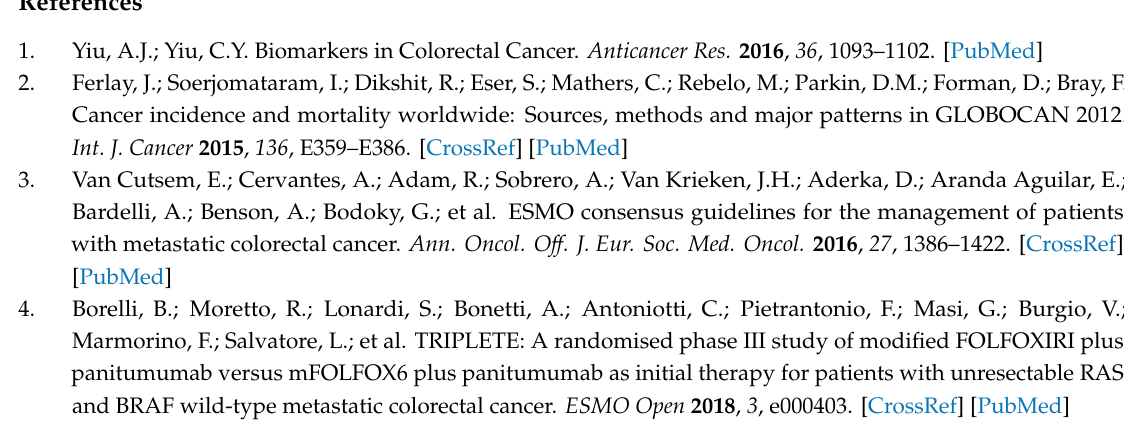
Table S1: Supplemental data. Specific ddPCR Assay